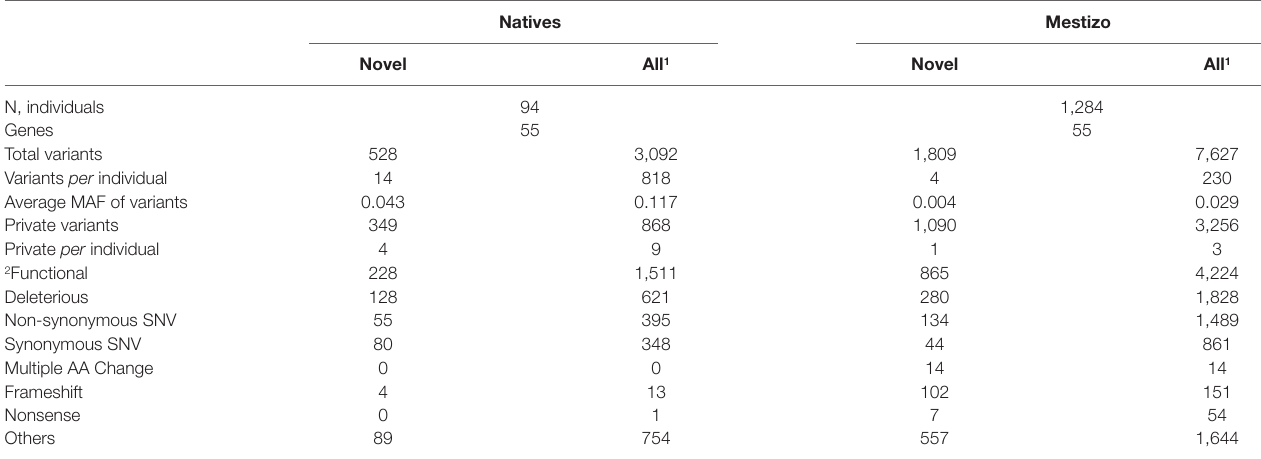
TABLE 1 | Variation in 55 pharmacogenes shared among cohorts.